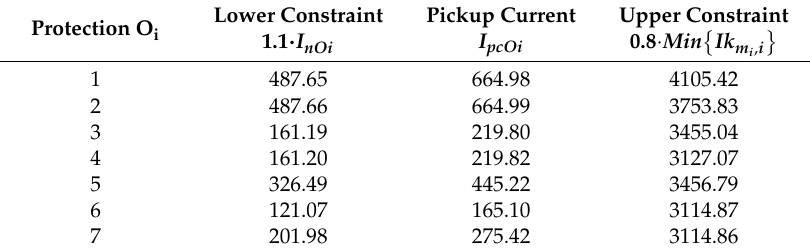
Table 6. Radial power system pickup currents and constraints (all values in A).